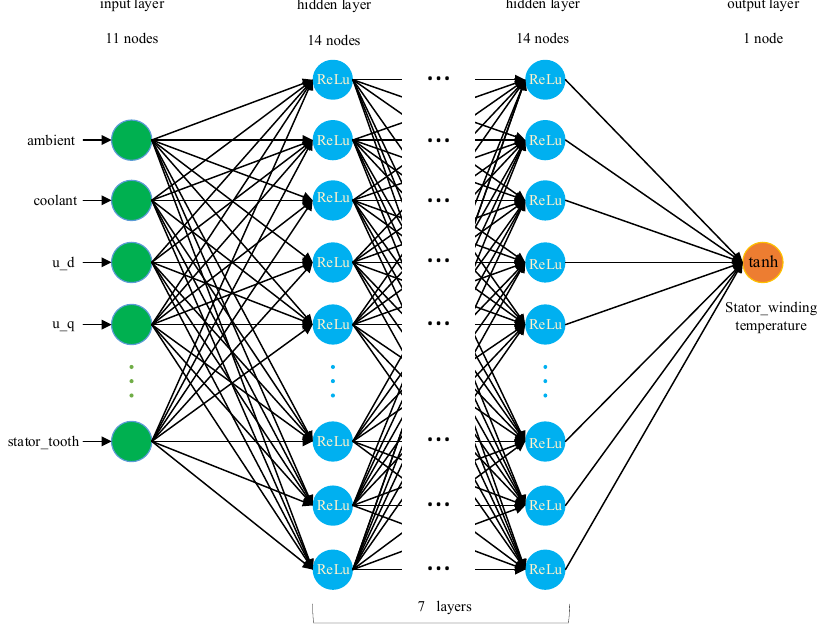
Figure 3. PMSM stator winding temperature prediction model.